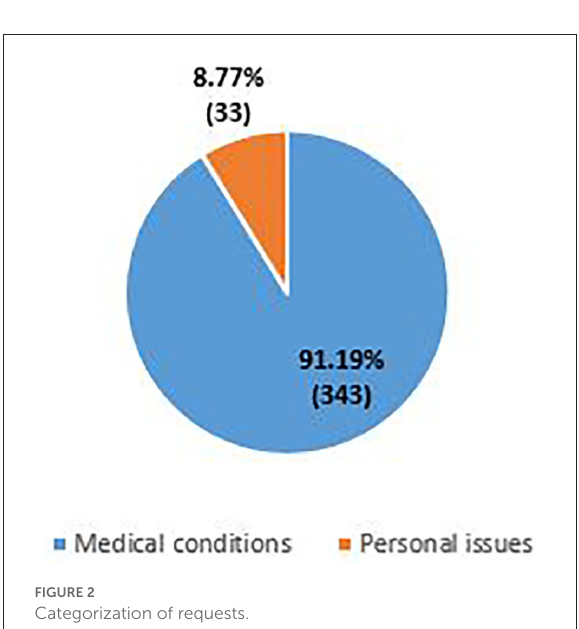
FIGURE2 Categorization of